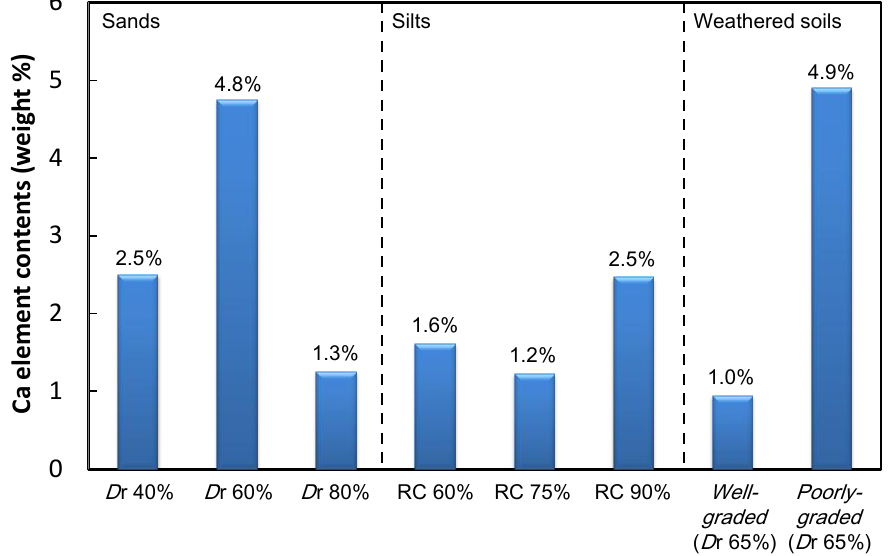
Figure 6. Ca contents (by wt%) depending on the ground